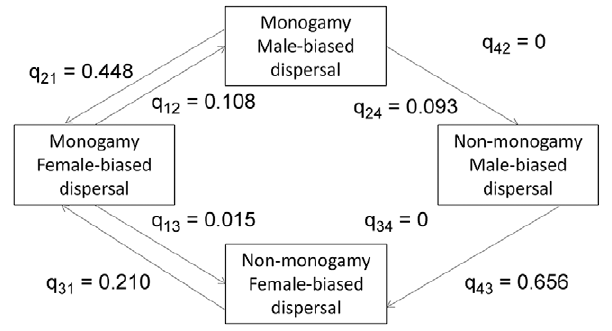
Figure 6. Path diagram showing evolutionary transition rates among four character states (avian dispersal distance dataset). Transitions from the ancestral state of monogamy and FBD to the derived state of non-monogamy and MBD for birds are shown. Arrow thickness is proportional to the magnitude of the transition rate.